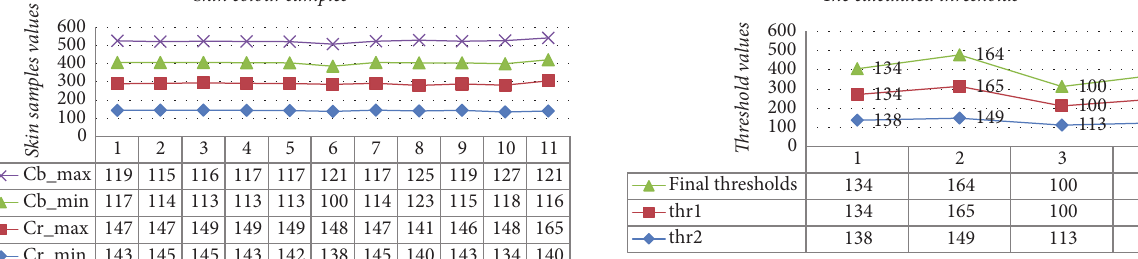
Figure 3: Manually extracted skin colour samples as maximum and minimum values in each Cb and Cr component from face region of eleven users.